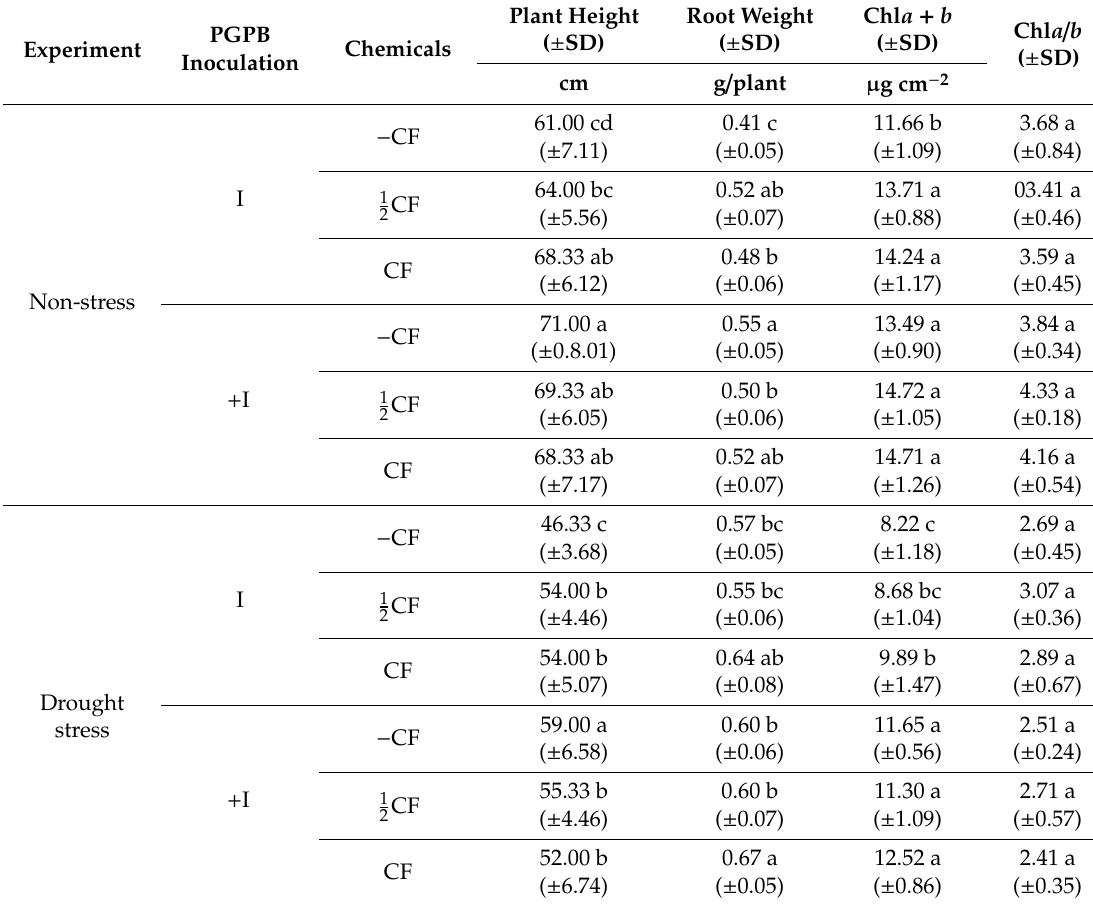
Table 4. Plant height, fresh weight of root, chlorophyll content (Chl a + b ), and the ratio of Chl a to Chl b in response to the chemical / microbiological fertilization management under non-stress, drought, and salinity